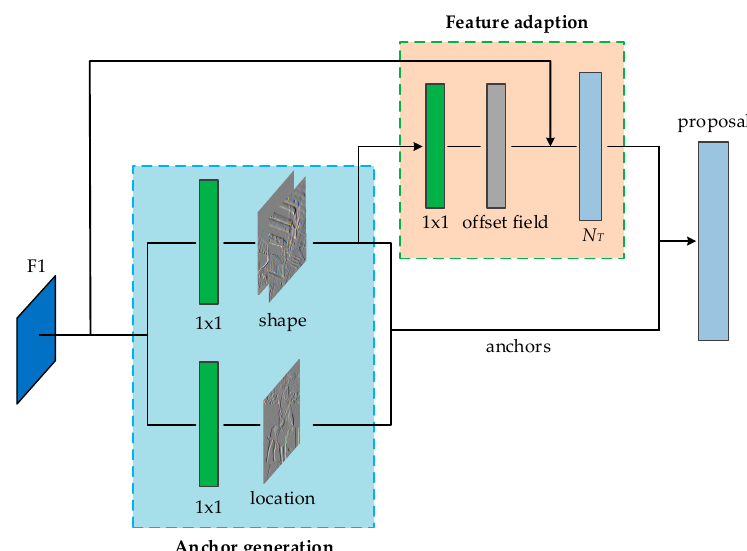
Figure 4. Architecture of guided anchor, based on anchor generation module with two branches to predict the anchor location and shape. Feature adaption module is applied to the feature map to make the new feature map aware of anchor shapes.